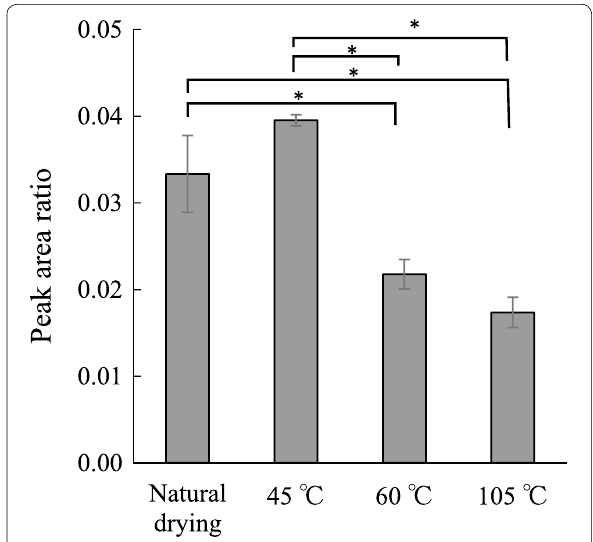
Fig. 9 The peak area ratio of abietadiene under different drying conditions to the peak area of naphthalene. The error bars show the standard deviation ( n 3). *:0.05 > p (Tukey =